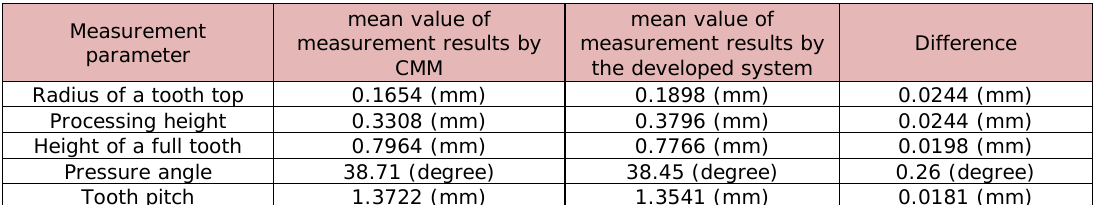
Table 2. “Accuracy analysis (front ten teeth)”.